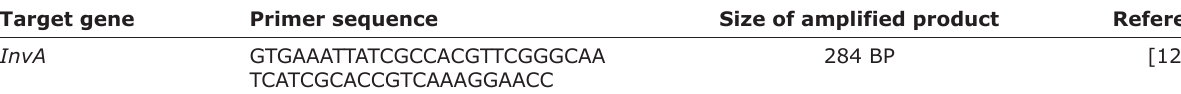
Table-1: Primer sequences for invA gene.